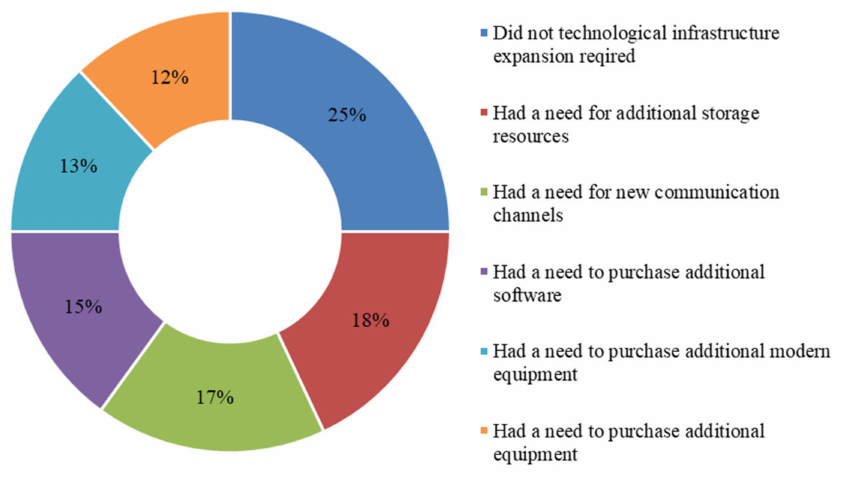
Figure 7. Changes that were required in the work and functioning of the infrastructure of ICT at the manufacturing enterprises of the Republic of